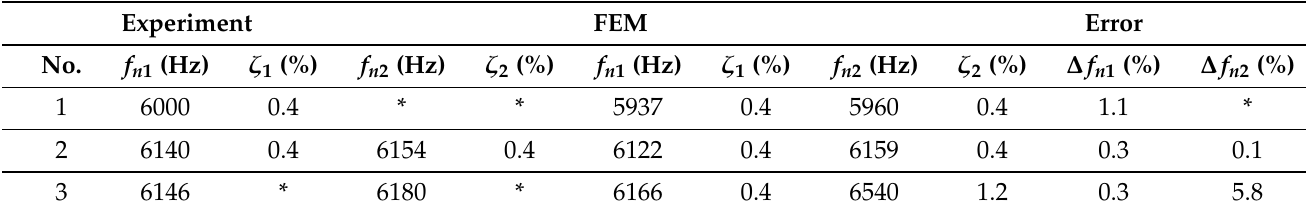
Table 4. Comparison of experimentally and numerically obtained eigenfrequencies f n 1 and f n 2 and modal damping ratios ζ 1 and ζ 2 for couples of (4,0) disc-bending